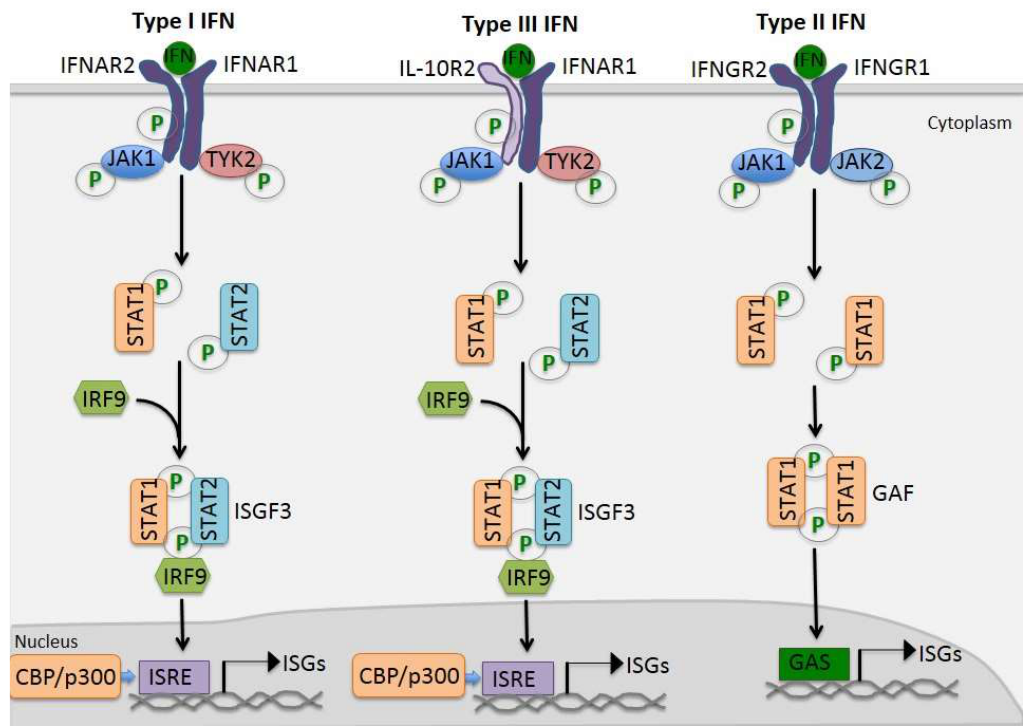
Figure 1. Schematic illustration of Type I, Type II, and Type III Interferon (IFN)